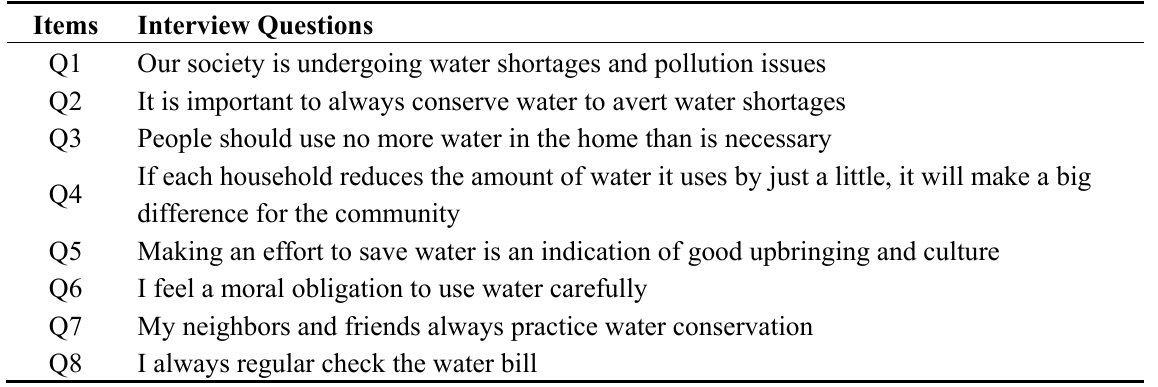
Table 2. Interview questions for indicators of water conservation consciousness [16,23].